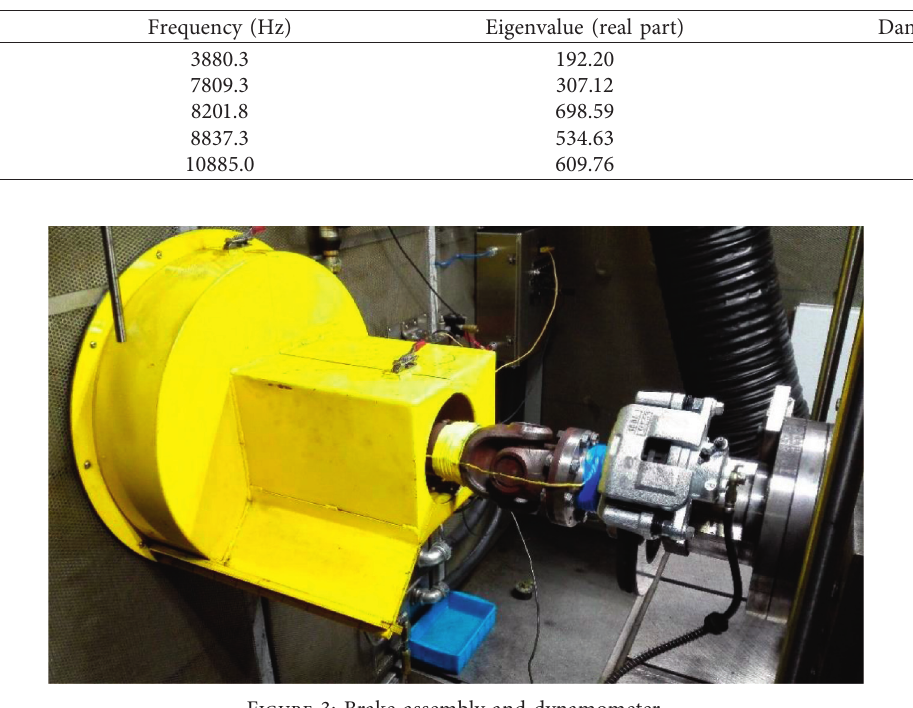
Table 3: Noisy modes in the finite element analysis.